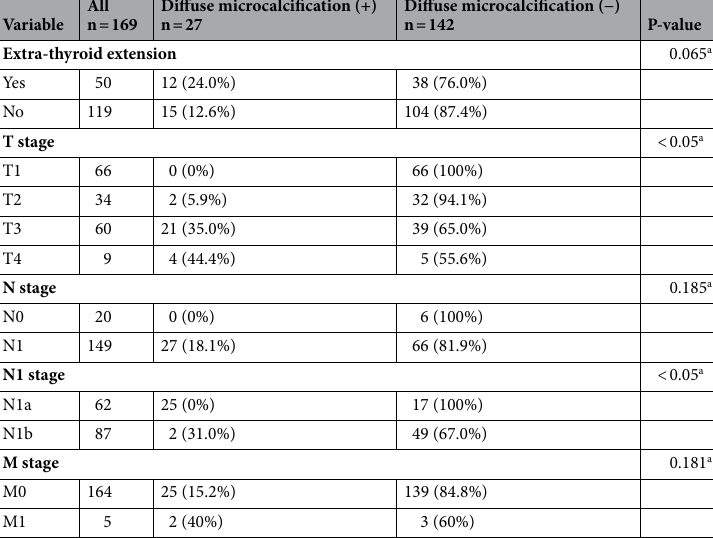
Table 2. The relationship between diffuse microcalcification and extra-thyroid extension and postoperative TNM staging. a Chi-square test.